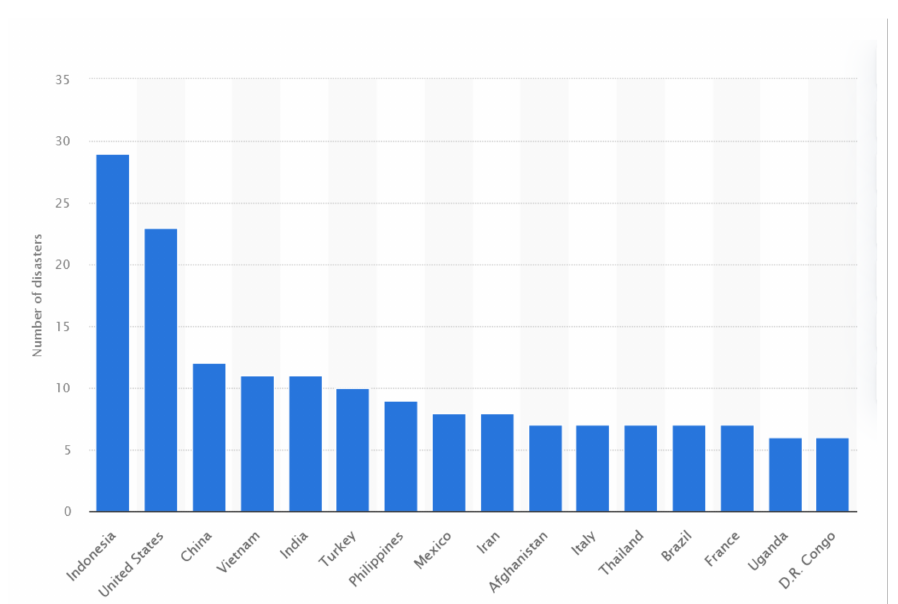
Figure 2. Countries with the most natural disasters in 2020